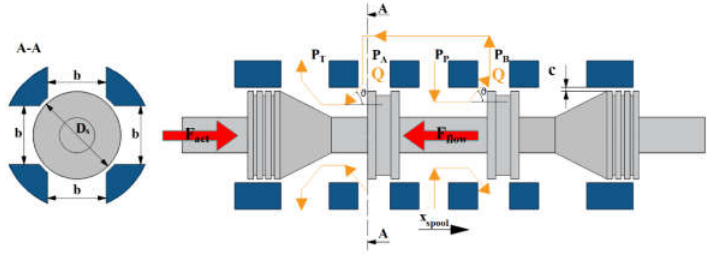
Figure 3. Sketch including the main parameters used in the numerical model.